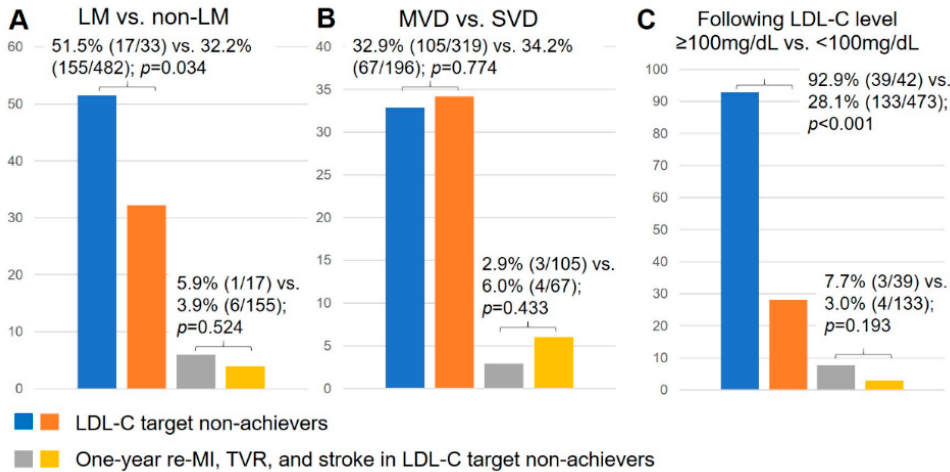
Figure 3. The comparison of subgroups between presence and absence of left main (LM) coronary artery disease, multiple vessel disease (MVD) and single vessel disease (SVD), following LDL-C level ≥ 100 mg / dL and < 100 mg / dL. ( A ): The comparison between the patients with or without LM coronary artery disease: 51.5% (17 / 33) patients with LM coronary artery disease and 32.2% (155 / 482) patients without LM coronary artery disease did not achieve LDL-C target ( p = 0.034). The incidence of a one-year re-MI, TVR, and stroke did not have a significant di ff erence between these two subgroups (LM vs. non-LM; 5.9% (1 / 17) vs. 3.9% (6 / 155); p = 0.524). ( B ): The comparison between the patients with MVD and SVD: 32.9% (105 / 319) patients with MVD and 34.2% (67 / 196) patients with SVD did not achieve LDL-C target ( p = 0.774). The incidence of one-year re-MI, TVR, and stroke was not significantly di ff erent between these two subgroups (MVD vs. SVD; 2.9% (3 / 105) vs. 6.0% (4 / 67); p = 0.433). ( C ): The comparison between the patients with following LDL-C level ≥ 100 mg / dL and < 100 mg / dL: 92.9% (39 / 42) patients with following LDL-C level ≥ 100 mg / dL and 28.1% (133 / 473) patients with following LDL-C level < 100 mg / dL did not achieve LDL-C target ( p < 0.001). The incidence of one-year re-MI, TVR, and stroke showed no significant di ff erence between these two subgroups (following LDL-C level ≥ 100 mg / dL vs. < 100 mg / dL; 7.7% (3 / 39) vs. 3.0% (4 / 133); p =